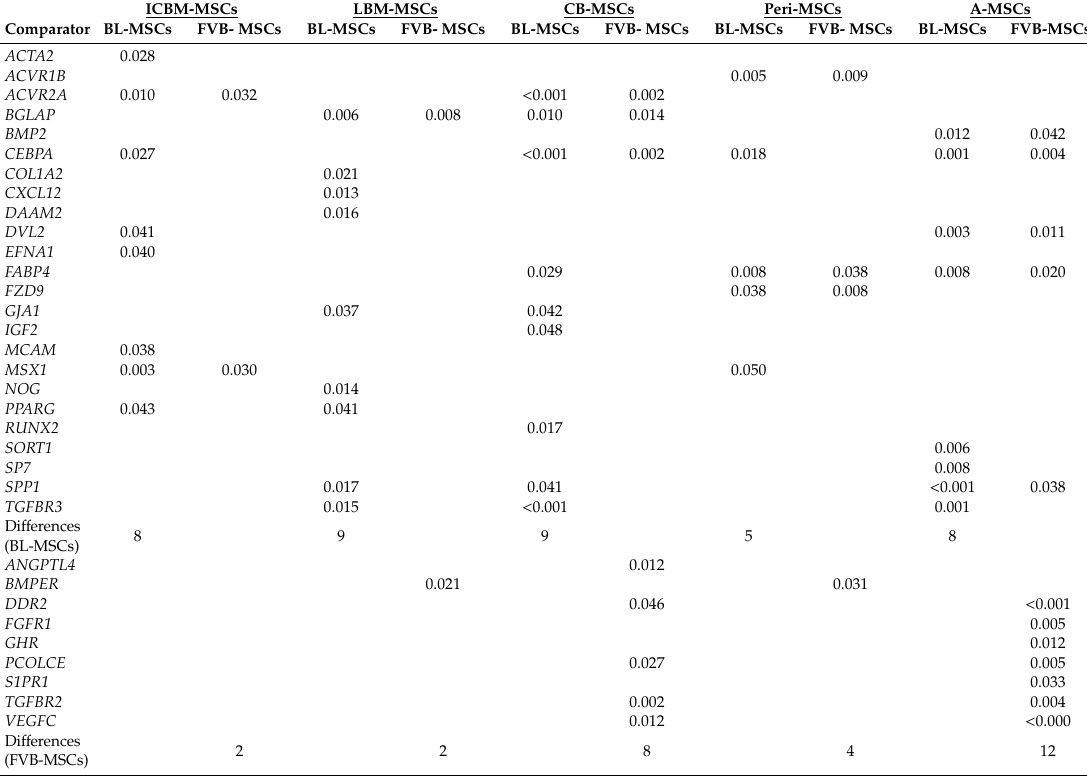
Top 24 genes are di ff erent ( p < 0.05) across all MSC types (Kruskal–Wallis) when all blood-MSCs ( n = 6) are considered, the bottom 9 genes are only di ff erent ( p > 0.05) when FVB-MSCs ( n = 4) are considered independently. Multivariate p values < 0.05 are shown. BL = blood, IC = iliac crest, LB = long-bone, CB = control bone, peri = periosteum, A = adipose.